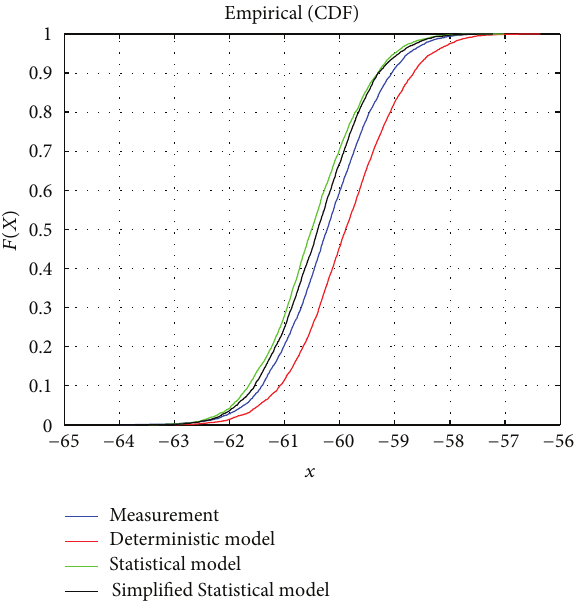
Figure 14: Channel capacity in